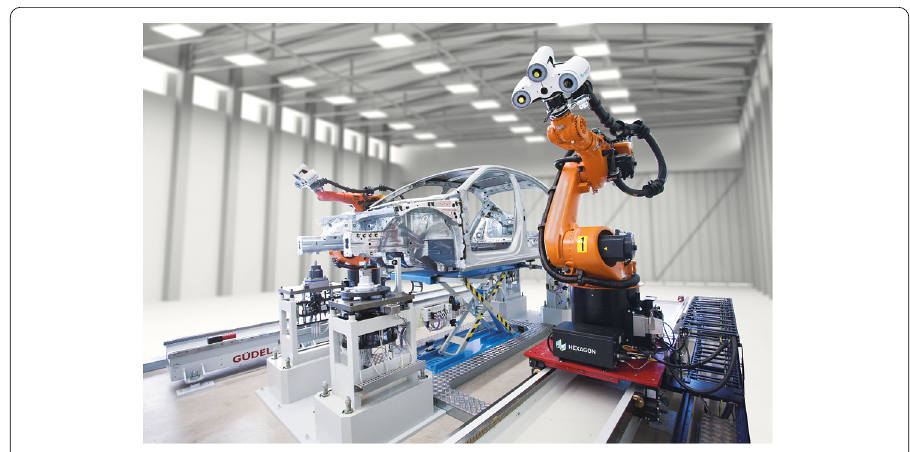
Figure 3 An exemplary setup of a 360 ◦ SIMS flexible measurement system. Image courtesy of Hexagon Manufacturing